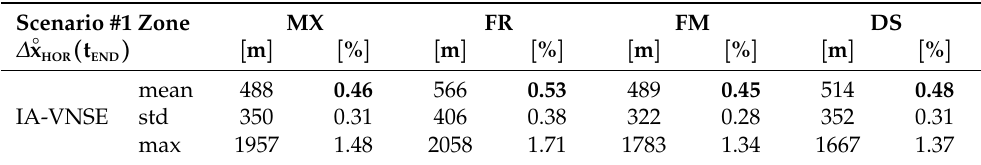
Figure 18. Influence of terrain type on horizontal position IA-VNSE for scenario #1 (100 runs). Table 7. Influence of terrain type on final horizontal position IA-VNSE for scenario #1 (100 runs). The most important metrics appear in bold.